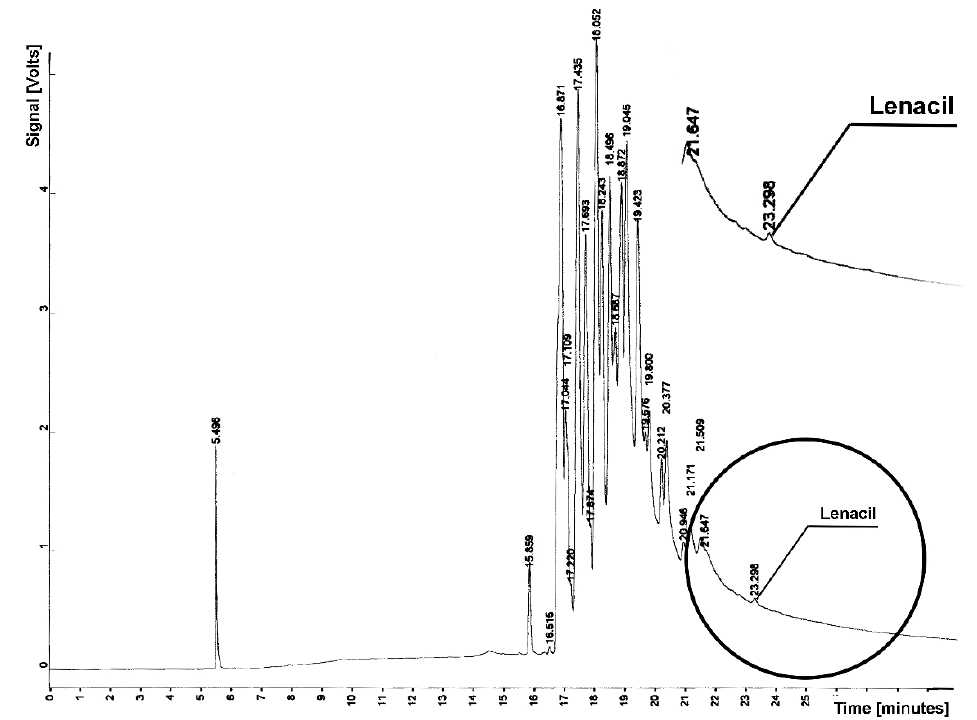
Figure 2. Chromatogram from determination of linuron residue in sample from soil extraction; tR = 16.072—linuron. tR = 16.072—linuron.